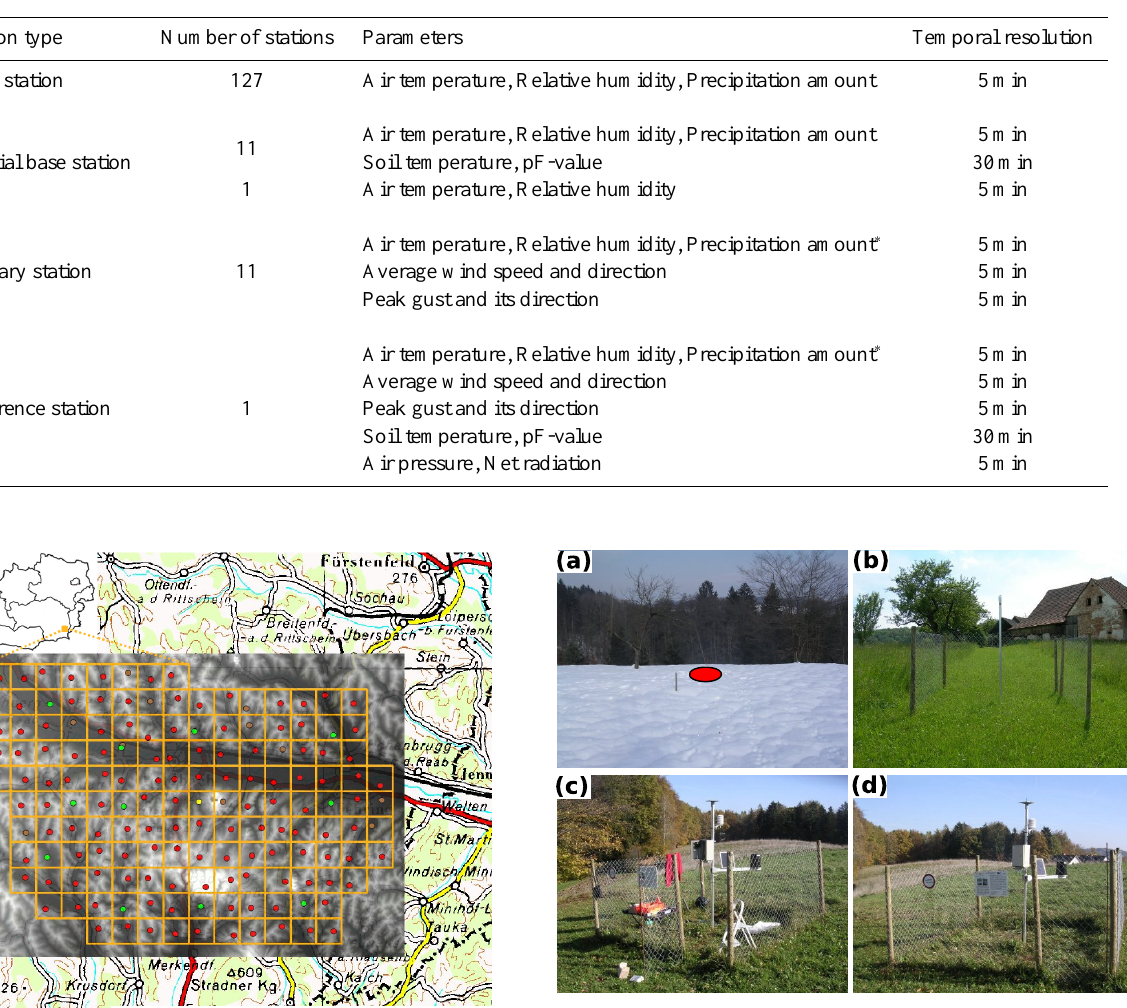
Table 1. Di ff erent types of WegenerNet stations and the measured parameters completed by their temporal resolution. Heated rain gauges are marked by ∗ .